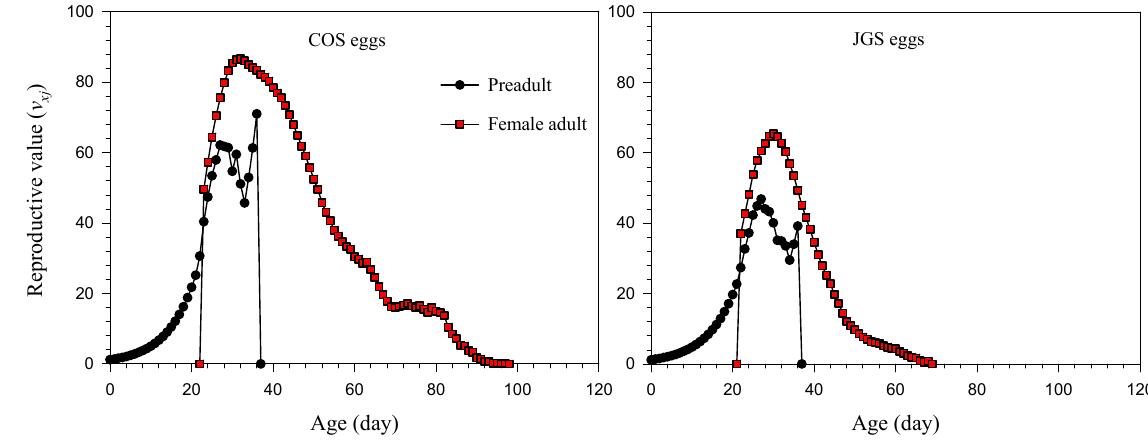
8 of 13 Figure 3. Life expectancy ( e xj ) of Anastatus japonicus parasitizing COS and JGS eggs. The reproductive value of A. japonicus ( v xj ) first gradually increased with age; reach- ing the peak at the ages of 32 days (86.69 d − 1 ) and 30 days (65.39 d − 1 ) when parasitizing